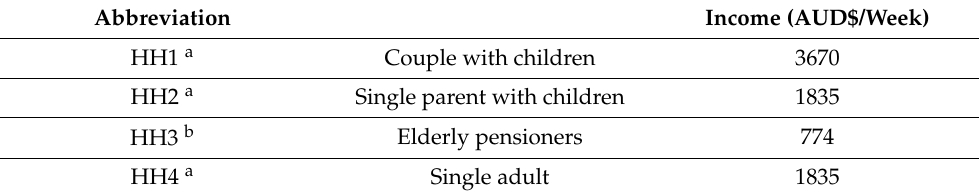
Table 2. Calculated income for the four reference